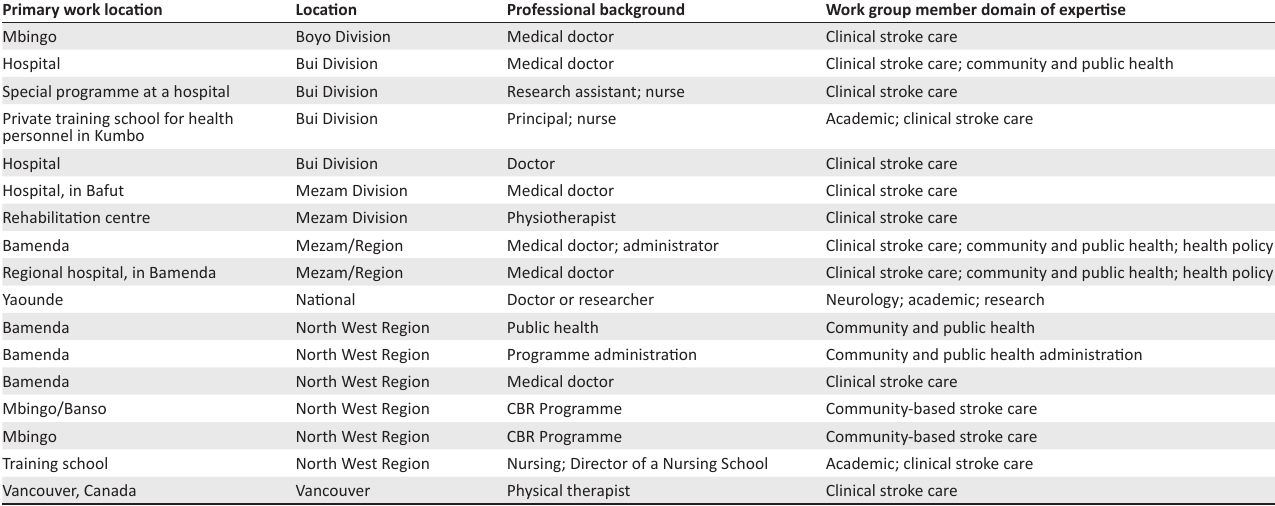
TABLE 2: Reviewer